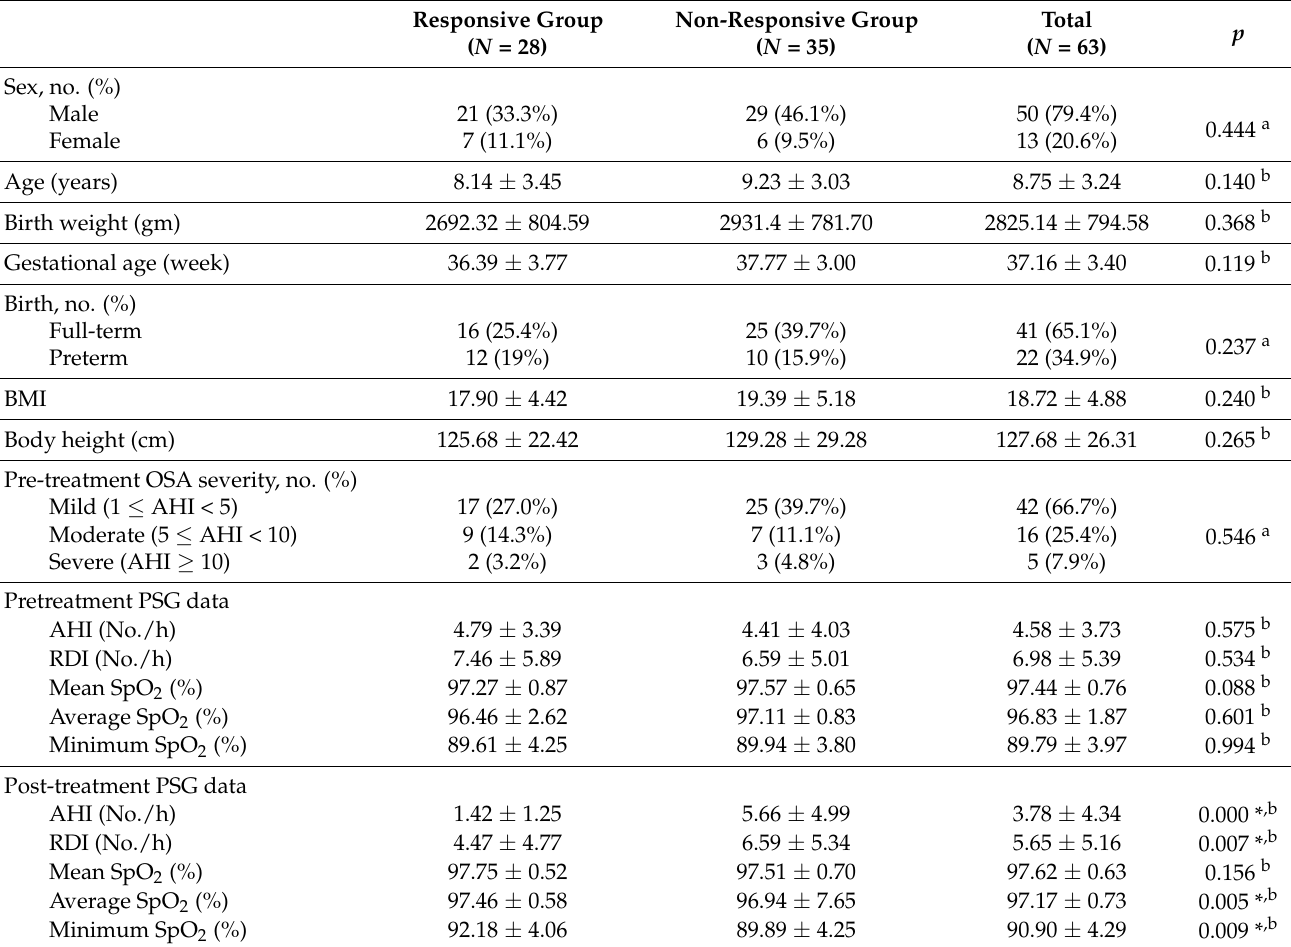
Table 1. Descriptive